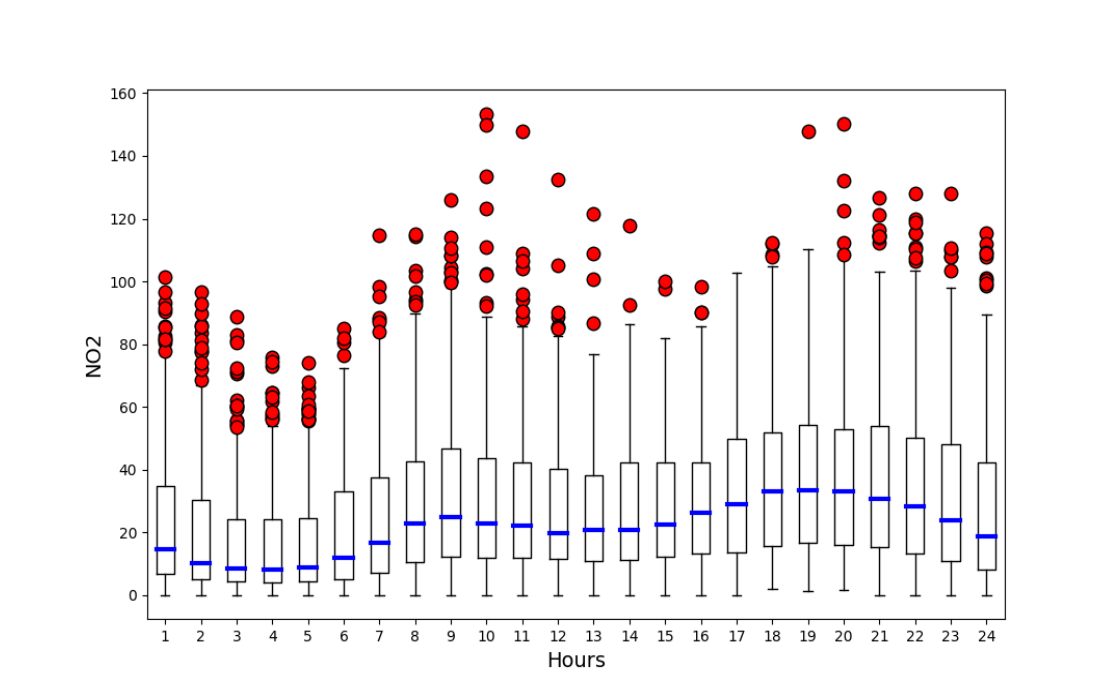
Figure 10. Hourly box plot of NO 2 concentrations from Blanchardstown air quality monitoring station. Software: Python